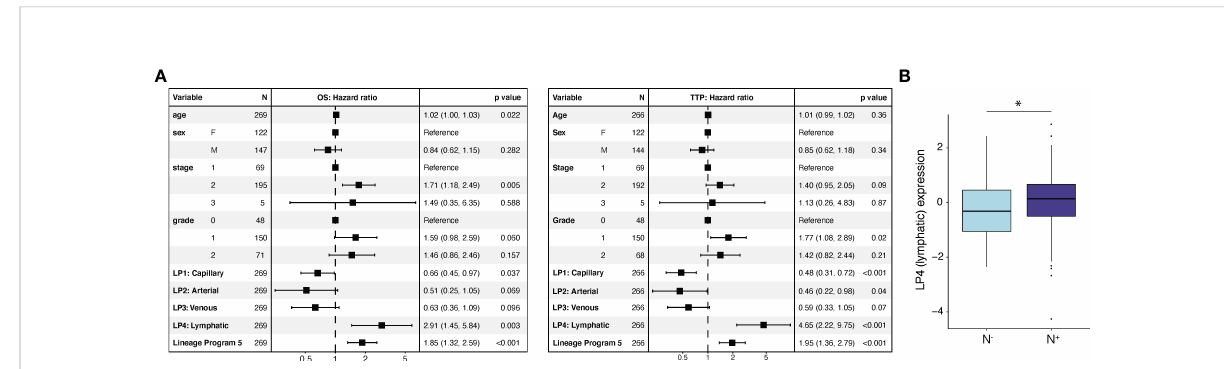
FIGURE 4 Lymphatic and reactive EndMT programs are associated with poor prognosis in independent bulk RNA-seq cohorts. (A) Endothelial lineage program expression and clinicopathological parameters associated with overall survival (OS; left) and time to progression (TTP; right) using a multivariable Cox regression analysis. *p value < 0.05, two-sided Mann-Whitney U test. (B) Lineage Program 4 (lymphatic) association with pathologically annotated lymph node involvement (N - , n = 69; N + , n = 210; p = 2.67 × 10 -2 , two-sided Mann – Whitney U test). Cox regression (A) and lymph node association (B) analyses use deconvolved bulk RNA-seq data from two independent cohorts of untreated, resected primary PDAC specimens [TCGA (9) ( n = 135) and PanCuRx (10, 11) ( n = 134) for Cox regression; TCGA ( n = 135) and PanCuRx ( n = 144) for lymph-node association]. LP, Lineage